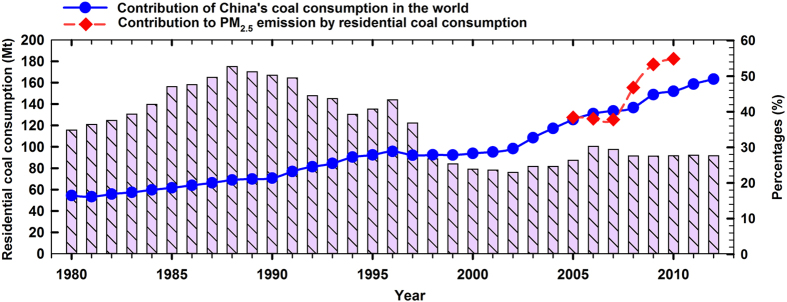
China’s residential coal consumption, the percentage of primary PM2.5 emission from residential coal consumption in that from all coal consumption activities in China, and the percentage of China’s coal consumption in global total coal consumption.Source: World Coal Association16, China Energy Statistical Yearbook50, and PM2.5 emission data from BAU model17.